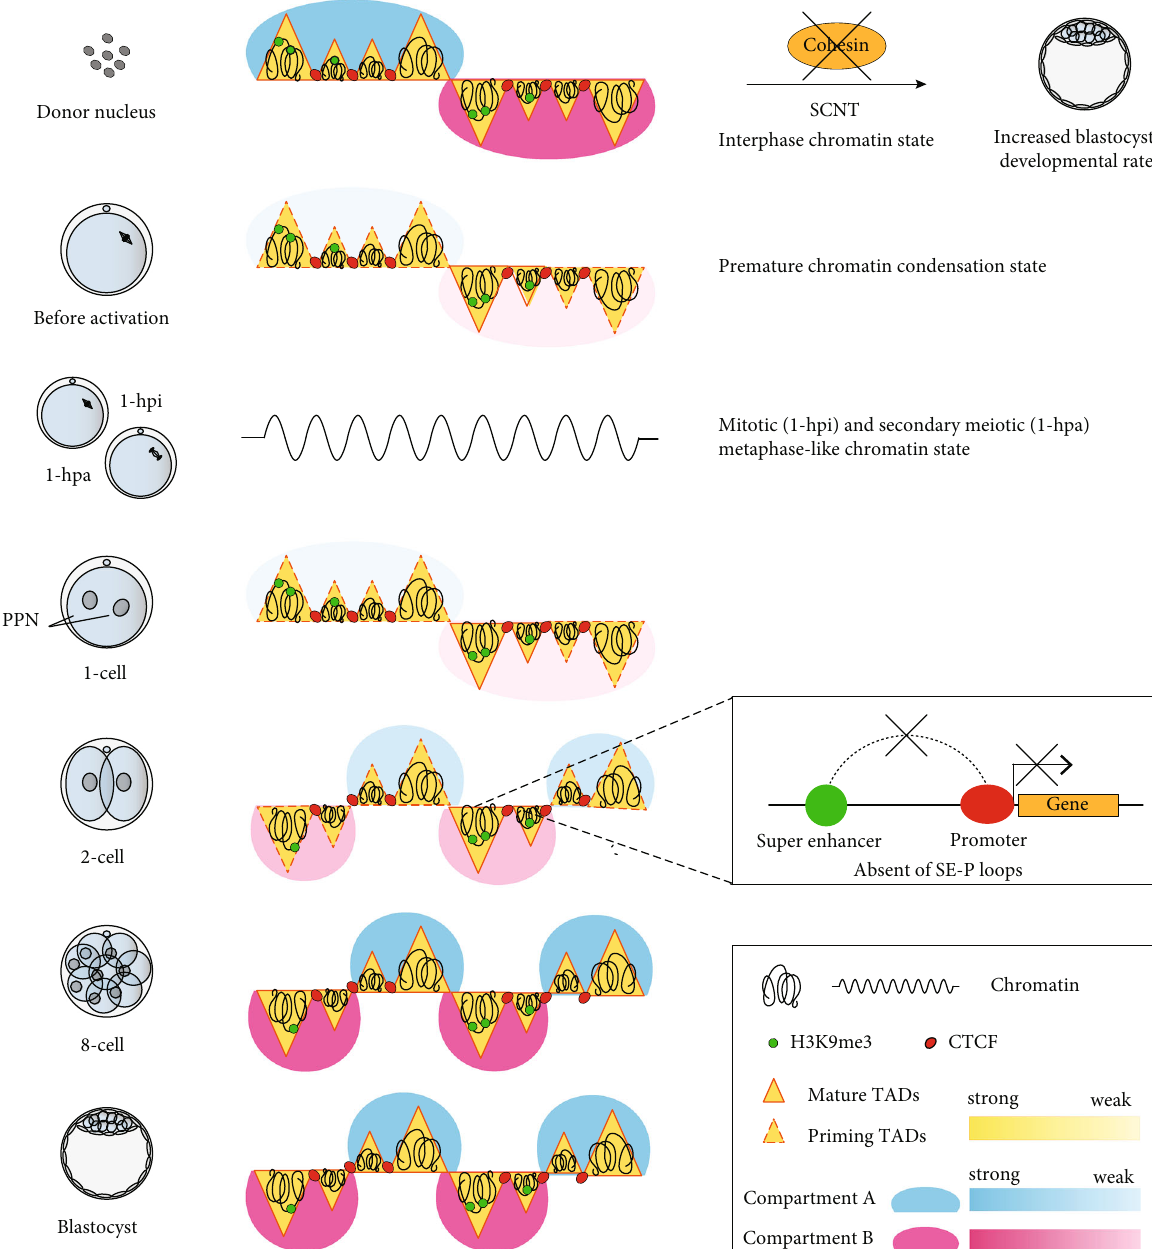
Figure 2: The higher-order chromatin organization in mouse SCNT embryos. Somatic donor cells exhibit interphase-state chromatin characterized by mature compartments and topologically associating domains (TADs). Before activated, the transferred nucleus fi rst enters a mitotic-like state (premature chromatin condensation) followed by exhibiting mitotic and secondary meiotic metaphase-like chromatin states lacking compartments and TADs 1 hour postinjection (1-hpi) and 1-hour postactivation (1-hpa), respectively. TADs are stronger in SCNT 1-cell stage embryos and then become weaker at the 2-cell stage and gradually consolidating. Super enhancer-promoter (SE-P) loops that exist in fertilized 2-cell embryos are absent in SCNT 2-cell embryos, which is correlated with aberrant H3K9me3 and TAD persistence. Compartments A/B are markedly weak in 1-cell SCNT embryos and become increasingly strengthened afterward. By the 8-cell stage, somatic chromatin architecture is largely reset to embryonic patterns until the blastocyst stage. Predepleting cohesin in donor cells increases SCNT reprogramming e ffi